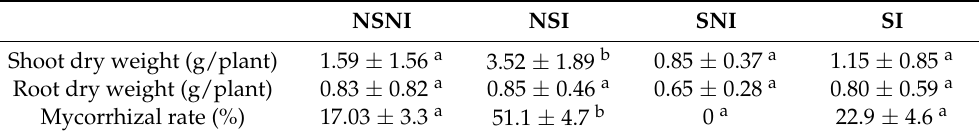
Table 2. Plant biomasses and root mycorrhizal rates obtained in agricultural soil (soil F). NSNI NSI SNI SI Shoot dry weight